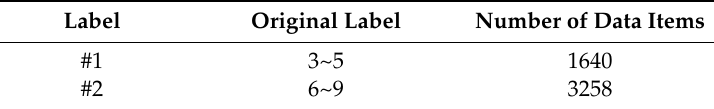
Table 2. Wine quality